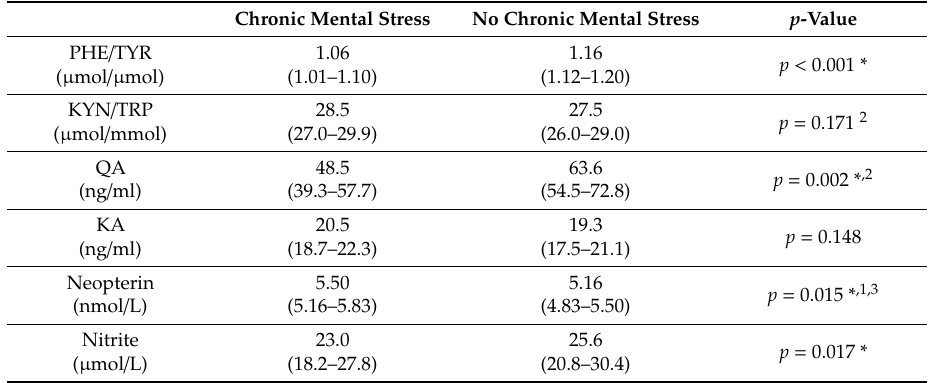
Table 3. The e ff ect of chronic mental stress on neurotransmitter precursor amino acid levels, derived biogenic amines, neopterin and